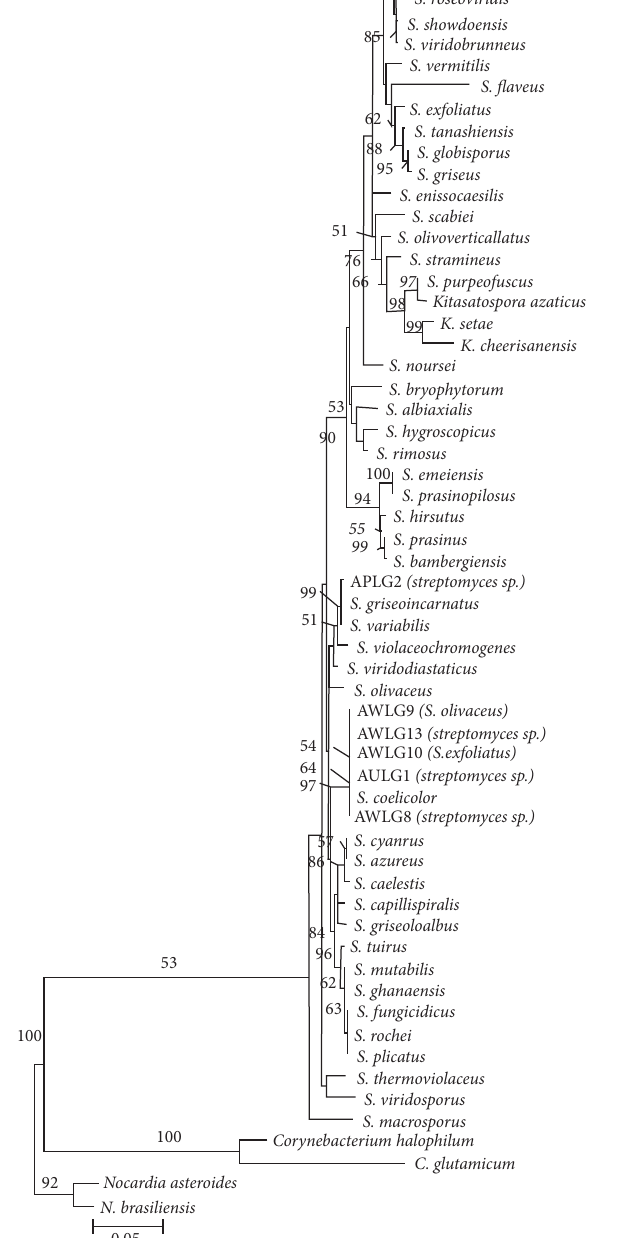
Figure 4: Neighbor-joining tree of the genus Streptomyces based on 1337 nucleotides of the 16s rRNA gene using the TIM1+I +G model of DNA substitution. The tree is rooted on members of Nocardia, Kitasatospora, and Corynebacterium. Values on nodes represent percentage bootstraps out of 1000 bootstrap samples; values less than 50% are not shown. Scale bar represents five nucleotide substitutions for every one thousand